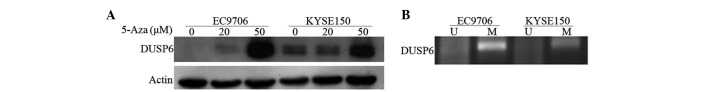
Methylation status of the DUSP6 promoter and intron 1. (A) Western blot analysis shows restoration of DUSP6 expression in two ESCC (EC9706 and KYSE150) cell lines after demethylation treatment by 5-aza-2′-deoxycytidine at two different concentrations (20 and 50 μM). Restored DUSP6 expression in both ESCC cell lines varied according to the 5-aza-2′-deoxycytidine concentration. (B) Methylation-specific PCR analysis: The region from +544 to +627 in intron 1 of the DUPS6 gene was PCR-amplified with primers specific for either methylated or unmethylated DNA as a template. The products were resolved by electrophoresis in 3% agar and stained with ethidium bromide. DUSP6, dual-specificity phosphatase 6; ESCC, esophageal squamous cell carcinoma; 5-Aza, 5-aza-2′-deoxycytidine; U, unmethylated; M, methylated.